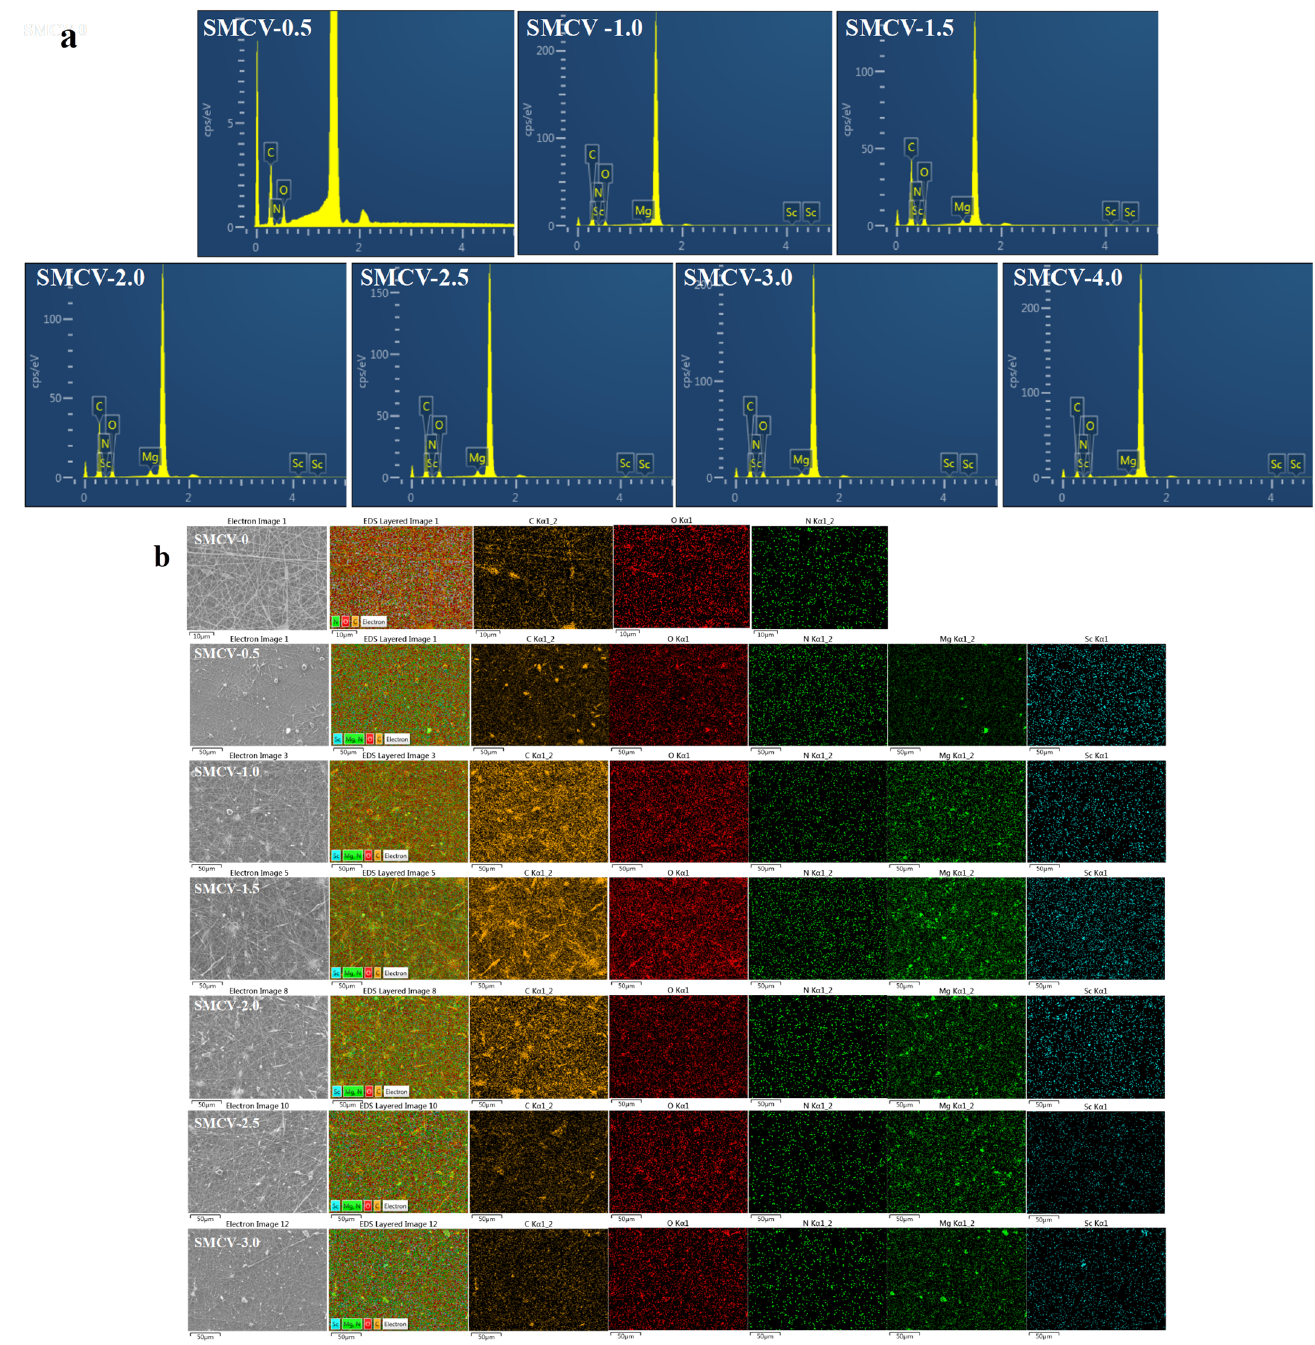
Figure 2. The elements analysis: ( a ) EDS spectrum of SMCV (SMCV ‐ 0, SMCV ‐ 0.5, SMCV ‐ 1.0, SMCV ‐ 1.5, SMCV ‐ 2.0, SMCV ‐ 2.5, and SMCV ‐ 3.0); ( b ) The elemental mapping of SMCV (SMCV ‐ 0, SMCV ‐ 0.5, SMCV ‐ 1.0, SMCV ‐ 1.5, SMCV ‐ 2.0, SMCV ‐ 2.5, and SMCV ‐ 3.0). The results show that as the content of Sc 2 O 3 ‐ MgO increases from 0.5 wt% to 3.0 wt% (SMCV ‐ 0.5, SMCV ‐ 1, SMCV ‐ 1.5, SMCV ‐ 2.0, SMCV ‐ 2.5 and SMCV ‐ 3.0), the calculation results are consistent with Table 1 and Figure 2a. EDS mapping is a direct method of reflecting the dispersion of elements in a sample. As shown in Figure 2b, yellow dots, red dots, dark green dots, light green dots, and blue dots are derived from elements C, O, N, Mg, and Sc, respectively. It can be clearly seen that the color darkness of C and O in SMCV begins to brighten with the increase in the content of Sc 2 O 3 ‐ MgO, and gradually darkens when the load reaches 2 wt%. When the load of Sc 2 O 3 ‐ MgO